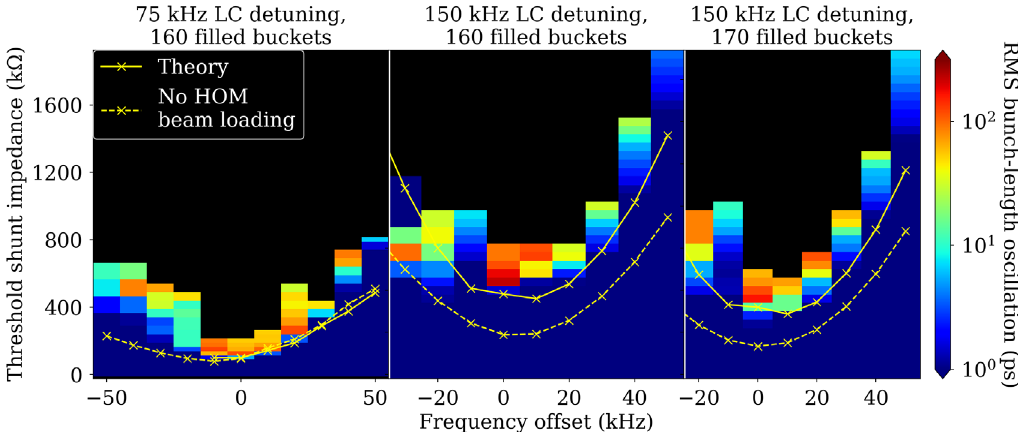
FIG. 4. Threshold shunt impedances above which a HOM-driven coupled-bunch quadrupole instability develops as determined by theory compared to the bunch length stability observed in macroparticle tracking shown on a color scale for different HOM frequencies and for three cases: a Landau-cavity detuning of 75 kHz and a 160 buckets filled (left), the same fill with a Landau-cavity detuning of 150 kHz (center) and a 150 kHz detuning with 165 buckets filled (right). Black indicates that no simulation was